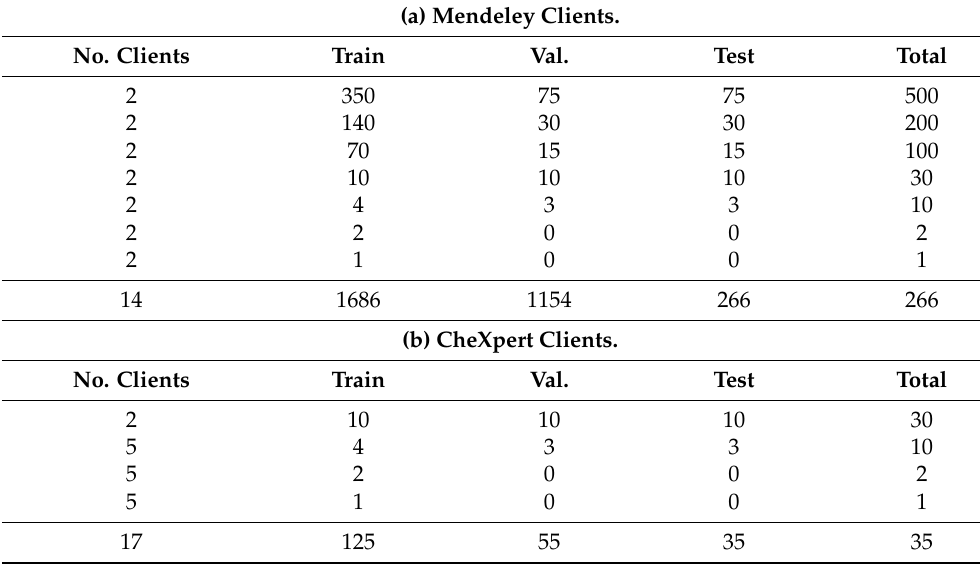
Table 2. Number of images from the Mendeley training dataset ( a ) and Chexpert validation dataset ( b ), distributed among 14 and 17 clients, respectively. We specify how many clients are included that hold the respective amount of data. The last row shows the total of previous rows, taking into account the number of